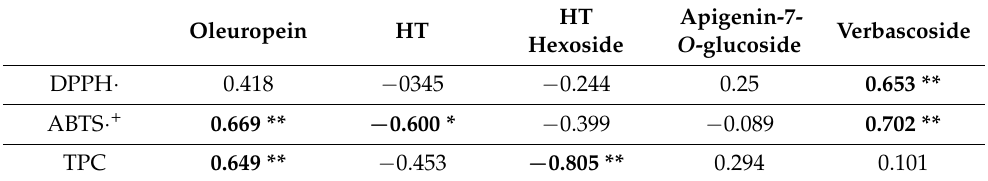
Table 3. Correlation between the concentration of phenolic compounds studied, antioxidant activity (DPPH · and ABTS · + ), and total phenolic compounds (TPC) in olive leaves.